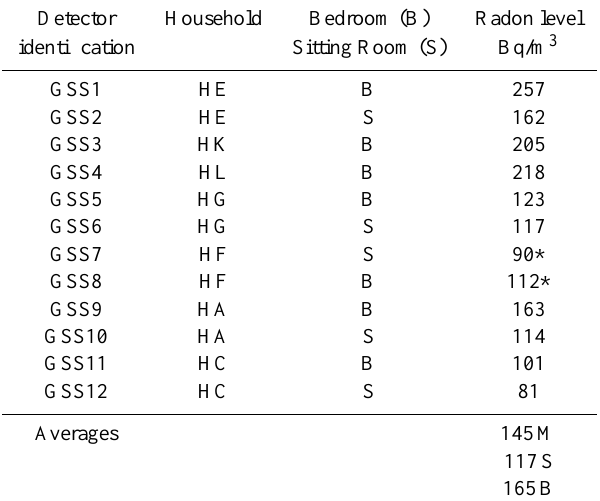
Table 3. Radon concentrations during the combined spring and summer period, for 146 days. The bottom line shows averages for sitting rooms (S), bedrooms (B) and the overall average (M). Dou- ble glazed property marked with a *.